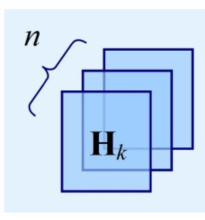
Figure 8. The inertial model. I-st level of the algorithm.